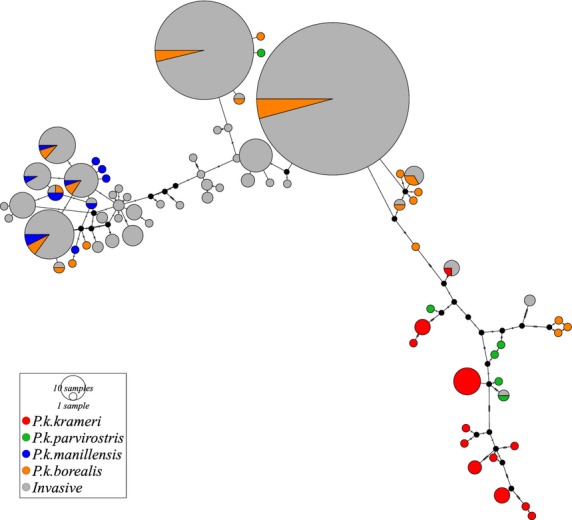
Median joining haplotype network comprising 44 mitochondrial (mtDNA) haplotypes shared between the native and invasive ranges, and an additional 30 haplotypes observed from the invasive range. Haplotypes from the invasive distributions are in grey. Native haplotypes are coloured according to the subspecies designation given on the label of each museum specimen; Asian subspecies = Psittacula krameri borealis, orange, and P. k. manillensis, blue; African subspecies = P. k. krameri, red, and P. k. parvirostris, green. Circles are proportional to haplotype frequency.